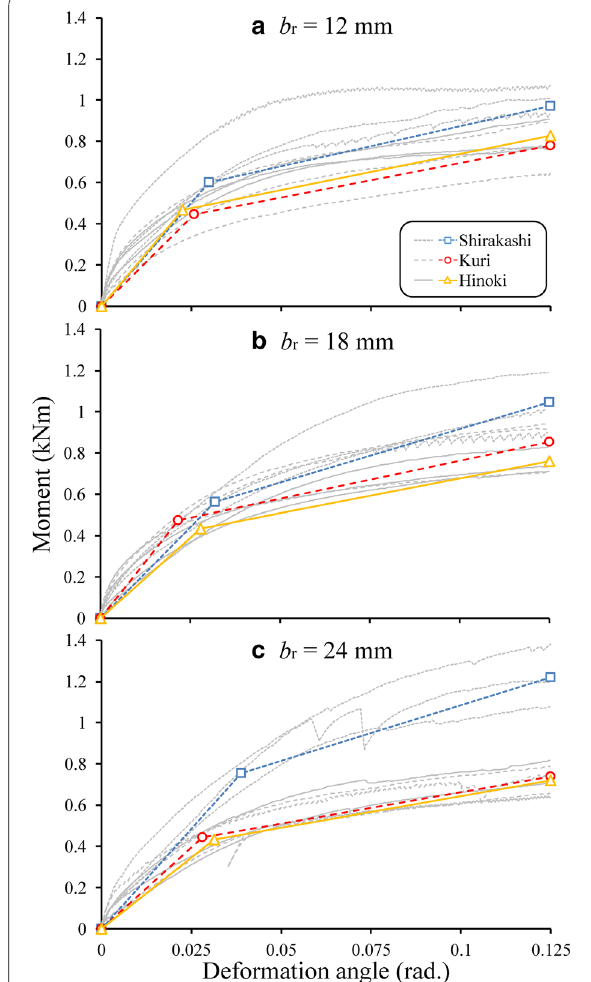
Fig. 6 Relations between moment and deformation angle and bilinear showing the average of characteristic (Rl series) [5]. See Fig.